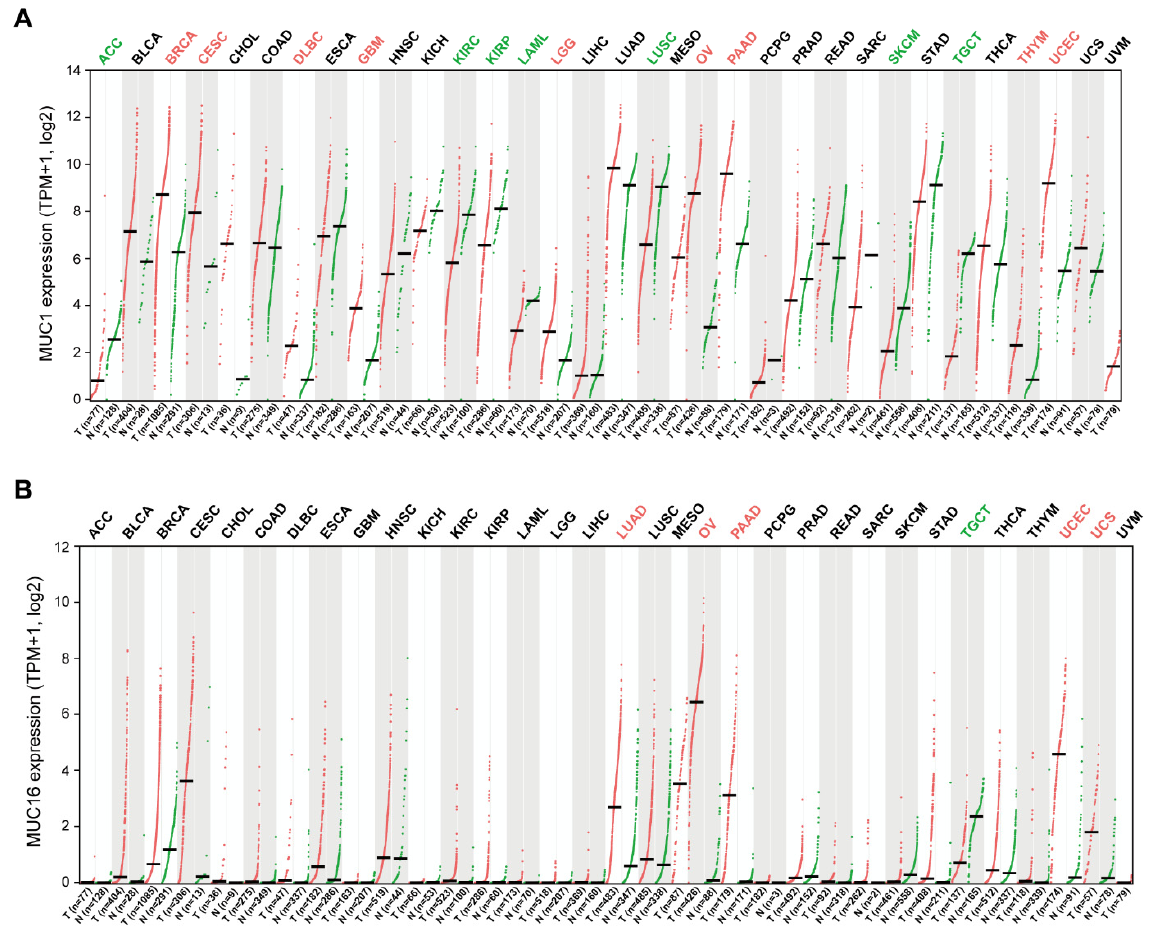
Figure 2. MUC1 and MUC16 mRNA expression in tumor and normal tissues. Pan-cancer expression analysis of MUC1 and MUC16 genes was conducted using the GEPIA2 web server [55]. Tumor tissues (T, red dots) represent TCGA tumors. Normal tissues (N, green dots) represent TCGA and GTEx normal tissues. Expression values are presented as log-normalized transcripts per million (TPM) with median values (horizontal black bar). The red and green colors of the cancer type abbreviations denote that MUC1 or MUC16 gene expression in significantly higher or lower in these tumor tissues compared with normal tissues. ( A ) MUC1 is overexpressed in tumors of the breast (BRCA), cervix (CESC), brain (GBM, LGG), B-cell (DLBC), pancreas (PAAD), ovary (OV), thymus (THYM), and uterus (UCEC). ( B ) MUC16 is overexpressed in tumors of the lung (LUAD), ovary (OV), pancreas (PAAD), and uterus (UCEC and UCS).